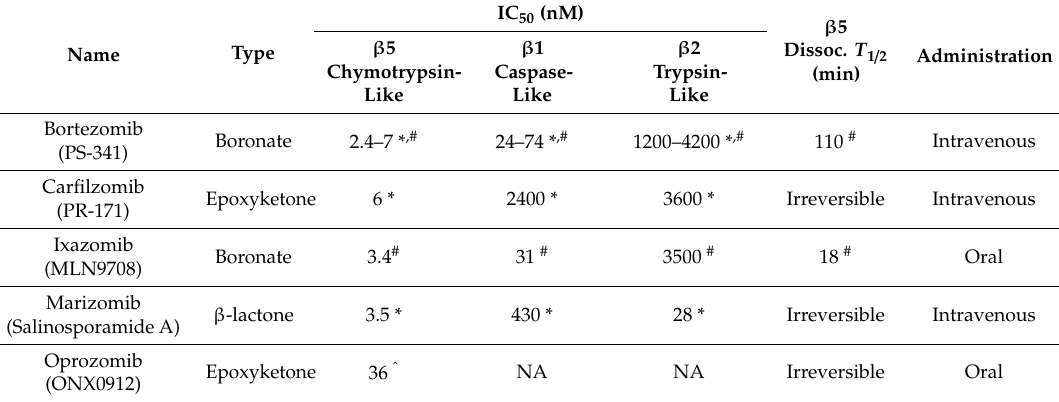
Table 1. Proteasome inhibitors in the clinic and in clinical